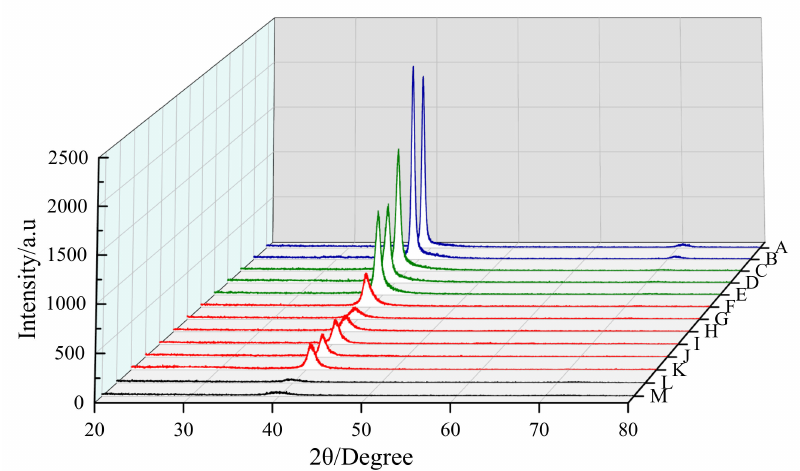
Figure 2. XRD patterns of (TiVCr)x-(TaW)1-x (A-M) binary system HEA